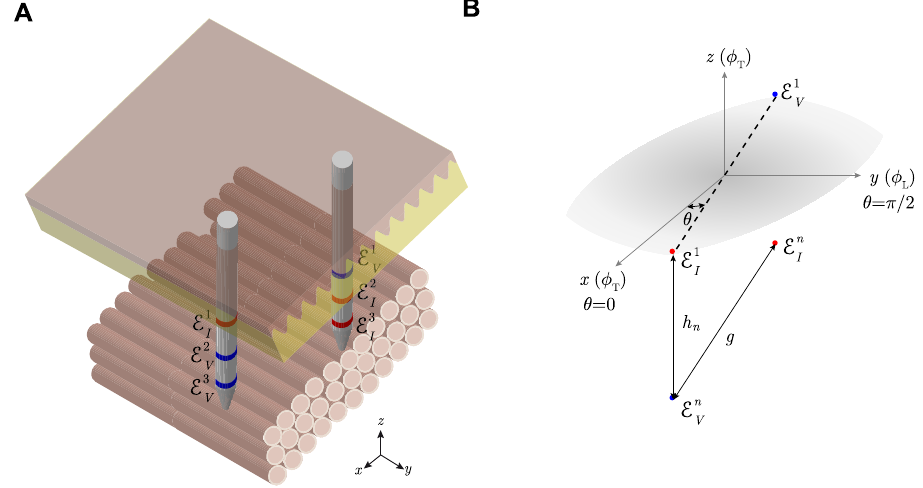
Figure 13. ( A ) Schematic showing the in situ measurement of anisotropic permittivity in N = 2 inter- electrodes’ distances using multipolar needles. N.b. compared to Fig. 12, there are more than one current and voltage electrodes in the z -direction within the same needle (in red and blue color, respectively). ( B ) Schematic of the n -th inter-electrodes’ distance measured in the z -direction. The measurement angle θ is defined with respect to the muscle fibers’ transverse (T) { x , z } direction φ T (i.e. φ T = θ when θ = 0) and φ L is the longitudinal y direction. Electrode